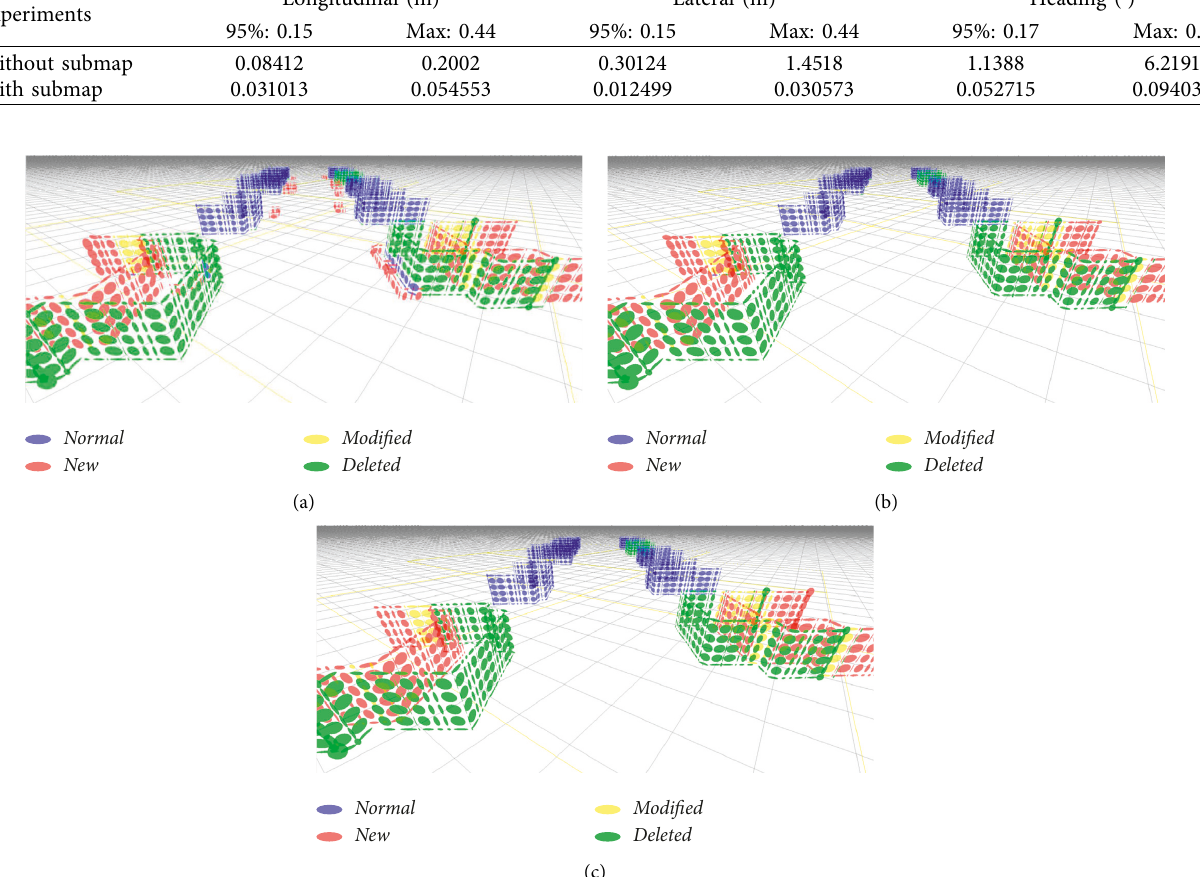
Figure 16: Map change information (a) detected by the map change detection algorithm based on single driving, (b) updated by the proposed framework based on crowd-sourced data, and (c) representing ground truth